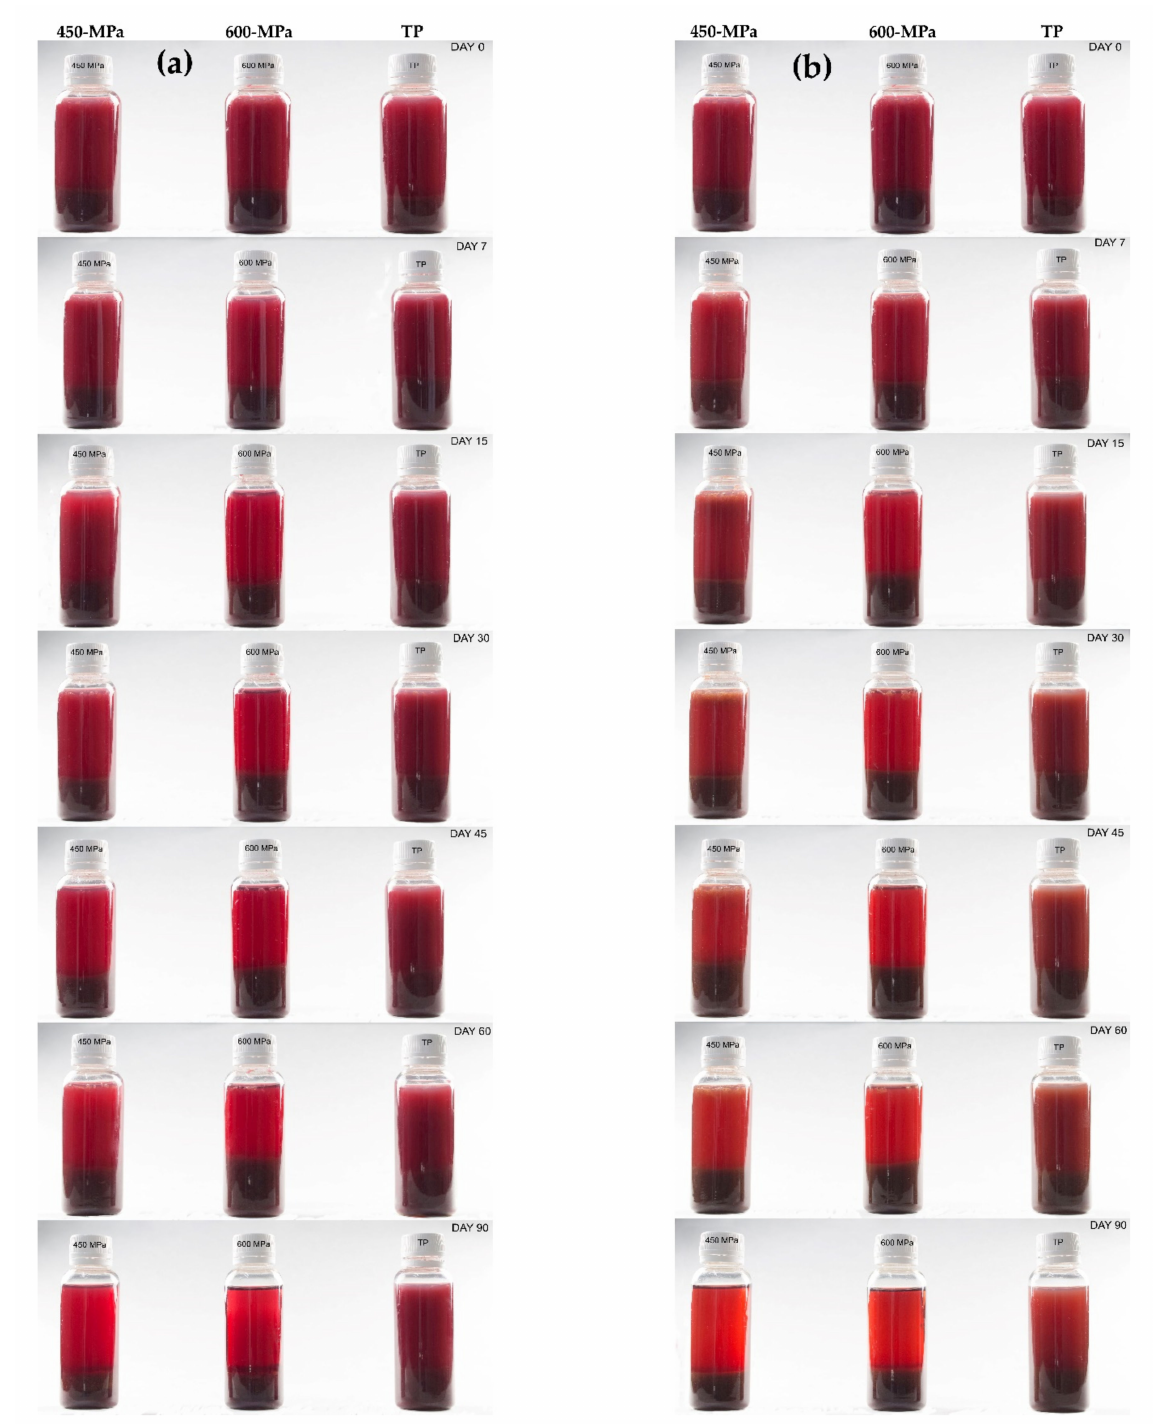
Figure 4. Visual appearance of citrus-maqui based beverages processed by HHP at different pressure levels (HHP—450 MPa and HHP—600MPa) and TP—85 ◦ C over 90 days of storage at 4 ◦ C ( a ) and 20 ◦ C ( b